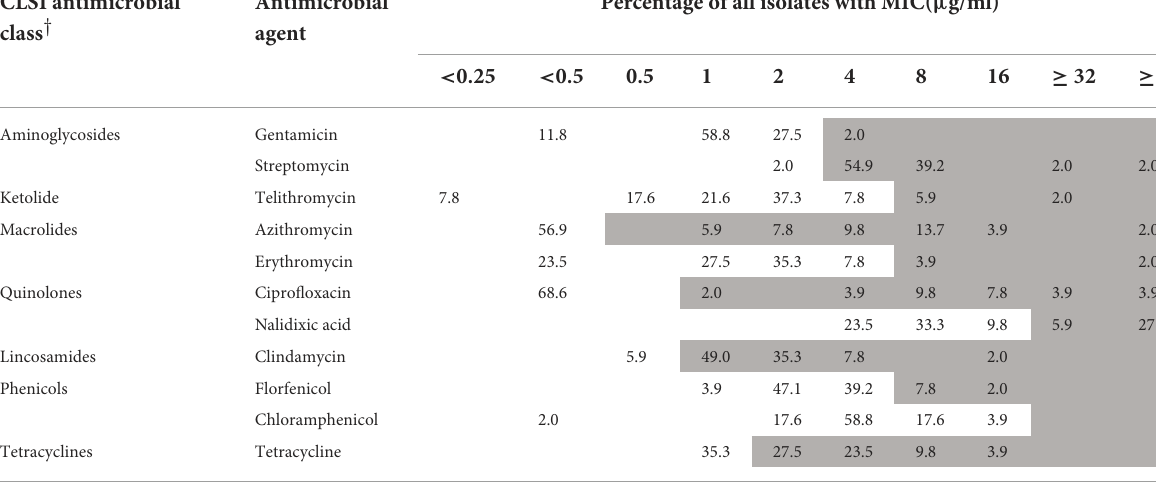
TABLE 1 Minimum inhibitory concentrations (MICs) of antimicrobial agents toward 51 A. butzleri isolates. CLSI antimicrobial